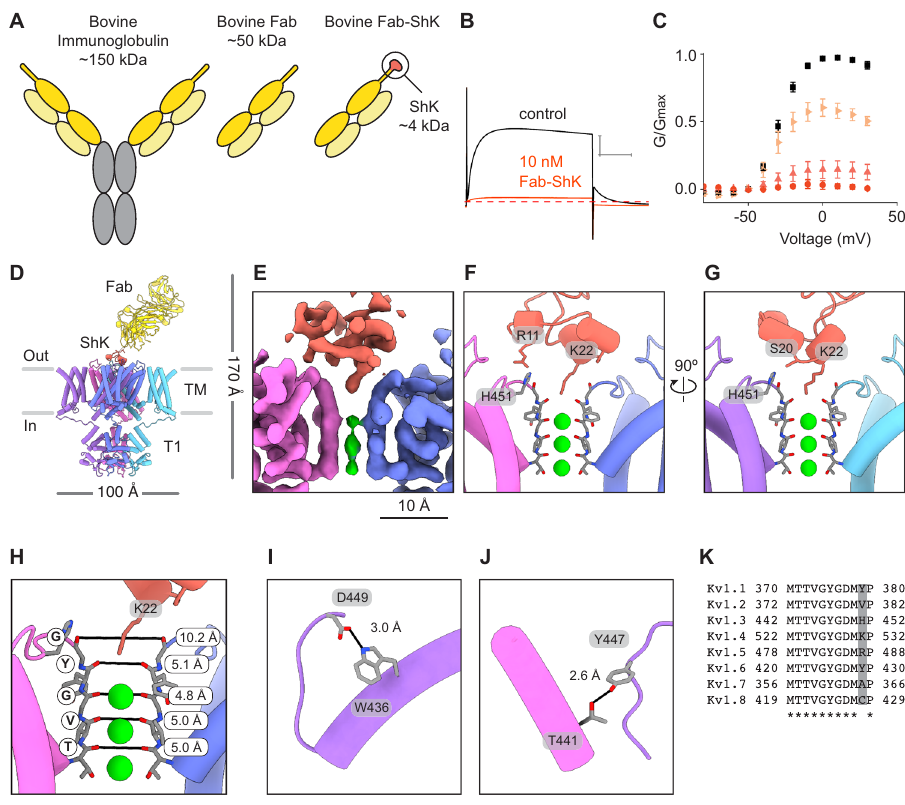
Fig. 5 Fab-ShK stabilizes a conductive pore conformation to block the channel. A Illustration of bovine antibody which has an elongated CDR3 region compared to human antibodies, bovine Fab fragment, and Fab-ShK fusion. B Kv1.3 current traces obtained by depolarizations to 0 mV from control 2 mM K + solutions (black) and in the presence of 10 nM Fab-ShK (orange). Holding voltage was − 80 mV and tail voltage was − 50 mV. Red dotted lined denotes zero current level. Scale bar indicates 5 μ A and 50 ms. C G-V relations obtained in control 2 mM K + solutions (black squares; n = 15), 0.1 nM (right facing light orange triangles; n = 4), 1 nM (upright pink triangles; n = 5) or 10 nM Fab-ShK (orange circles; n = 6) by measuring the peak of the tail current at − 50 mV and normalizing it to the maximum tail current in control solution. Error bars are SEM. D Model of Kv1.3 in complex with Fab-ShK as viewed from the side, with Fab and ShK colored yellow and orange, respectively. Close up views of ShK docking at the selectivity fi lter of Kv1.3. The map is displayed in E and the two views of the model in F , G . The ShK residue numbers correspond to ShK alone, not their numbering in the Fab-ShK fusion. The residues Arg11, Ser20, and Lys22 of ShK correspond to Arg118, Ser127, and Lys129 in the Fab-ShK fusion. H Structure of the selectivity fi lter of the Kv1.3- ShK complex. Distances between carbonyl oxygens of the TVGYG motif are reported and marked with black lines. I , J Key hydrogen bonds involved in channel gating are stabilized when Kv1.3 is bound by ShK. K Sequence alignment for the selectivity fi lters of Kv1 channels with the position for His451 of Kv1.3 highlighted. K + ions are shown in green in panels E – H . Source data are provided as a Source Data fi